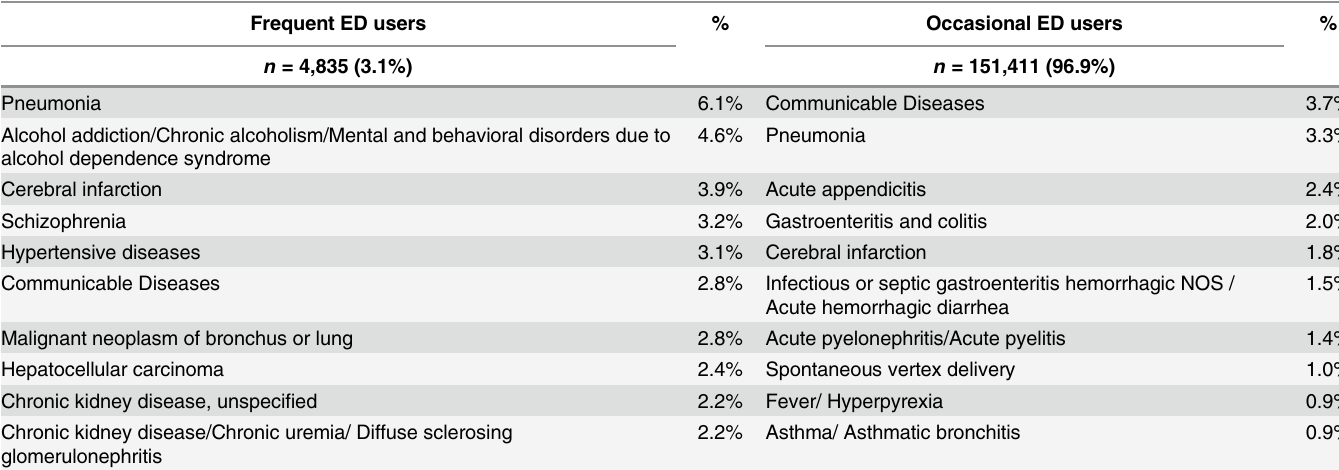
Table 3. Top 10 primary diagnoses in frequent and occasional ED